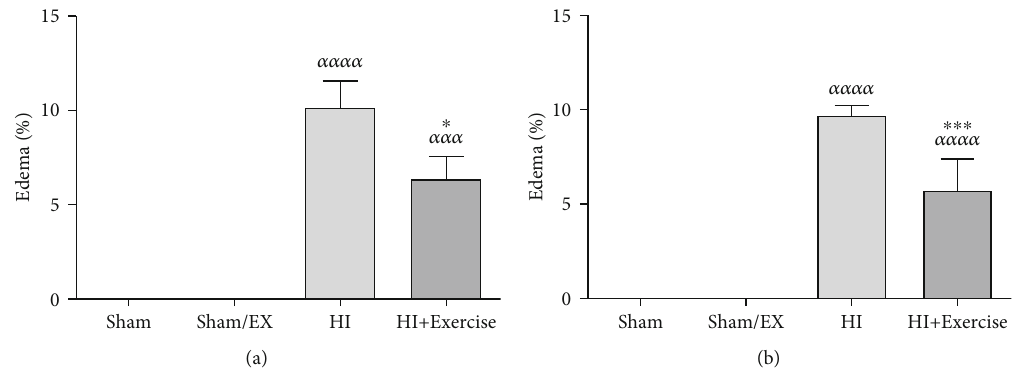
Figure 8: E ff ect of maternal exercise during pregnancy, on edema in the HI brain of female (a) and male (b) rat newborns. (c) HI: hypoxia- ischemia. ααα P < 0 : 001 , αααα P < 0 : 0001 as compared with the sham and sham/EX. ∗ P < 0 : 05 , ∗∗∗ P < 0 : 001 as compared with the HI. Data are expressed as the mean ± S : E : M : ( n = 10 ).